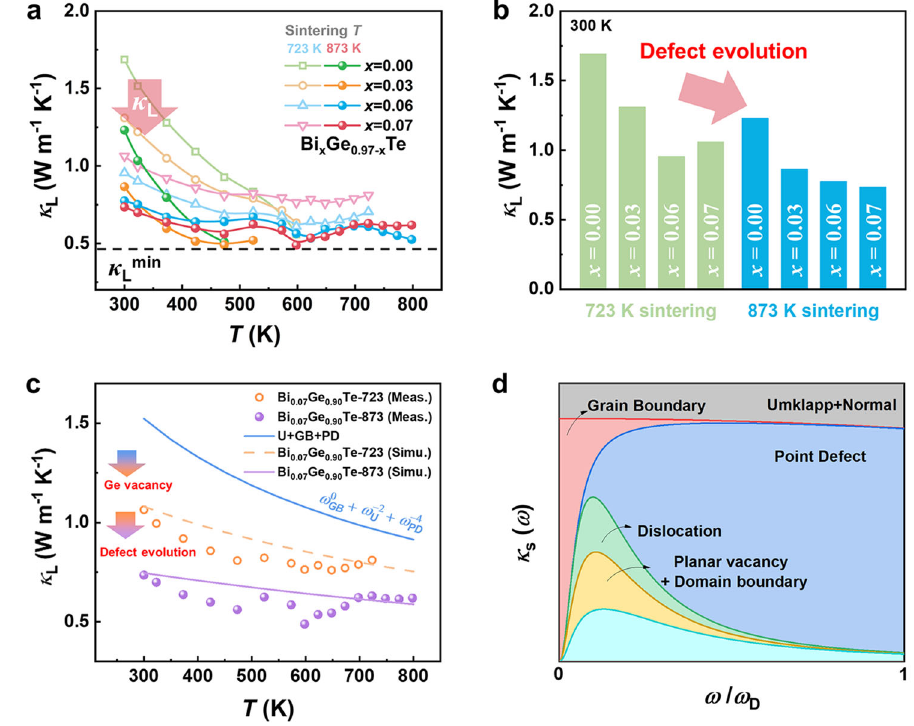
Fig. 3 | Lattice thermal conductivity and Debye-Callaway model prediction. a Temperature-dependent κ L for the Bi x Ge 0.97 – x Te-723 and Bi x Ge 0.97 – x Te-873 sam- ples, respectively. b The comparison of κ L at room temperature for the Bi x- Ge 0.97 – x Te-723andBi x Ge 0.97 – x Te-873samples. c Temperature-dependent κ L forthe Bi 0.07 Ge 0.90 Te-723 and Bi 0.07 Ge 0.90 Te-873 samples (symbols). The lines showing